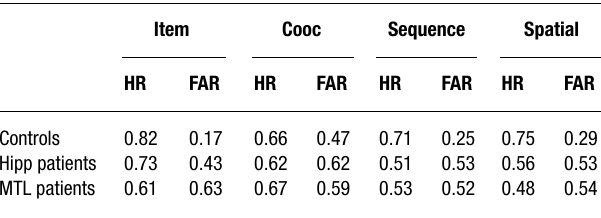
Table 3 | Hit and false alarm rates for controls and patients on each task in Experiment 1.